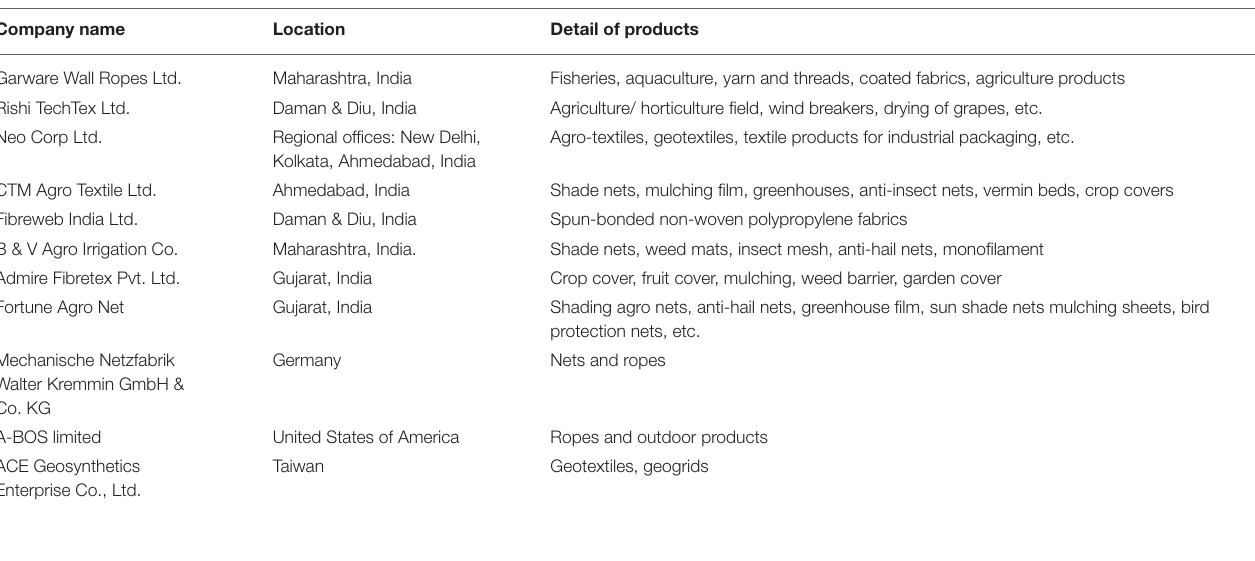
TABLE 1 | Agro-textile manufacturing companies around the globe (Indian Technical Textile Association, dataset taken from global agro-textile